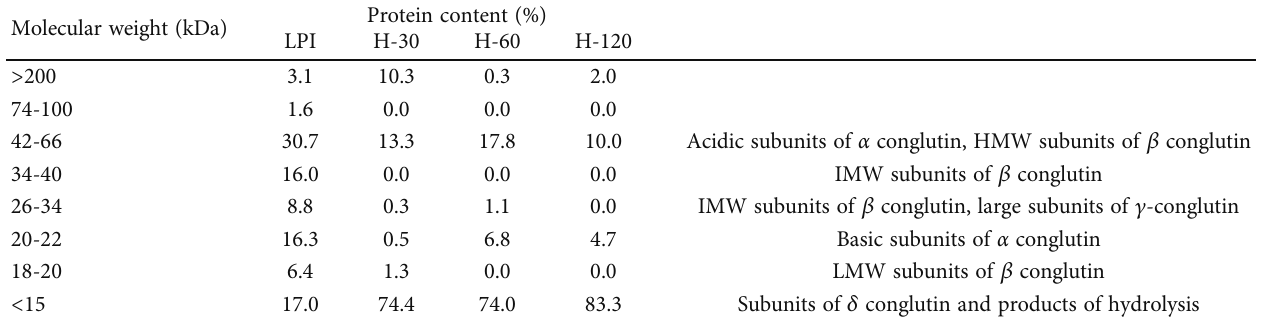
Table 1: Relative content (%) of protein fractions in lupin protein preparations (results of SDS-PAGE). Molecular weight